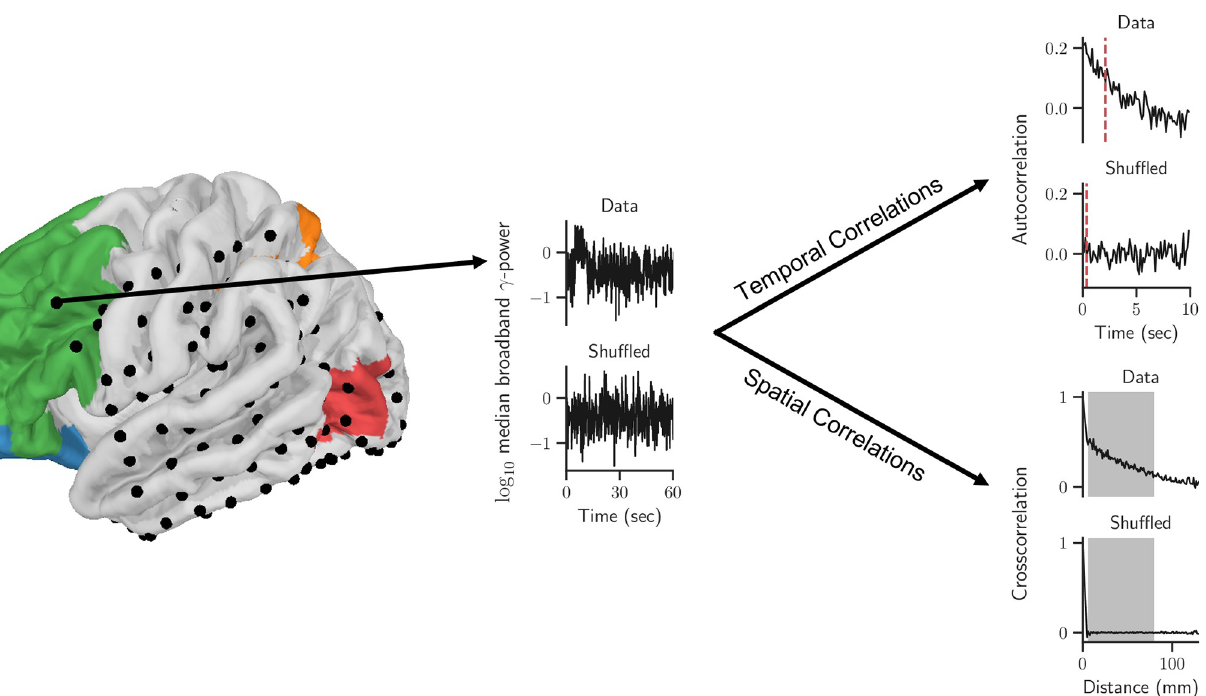
PLOS Computational Biology | https://doi.org/10.1371/journal.pcbi.1010919 March 3,